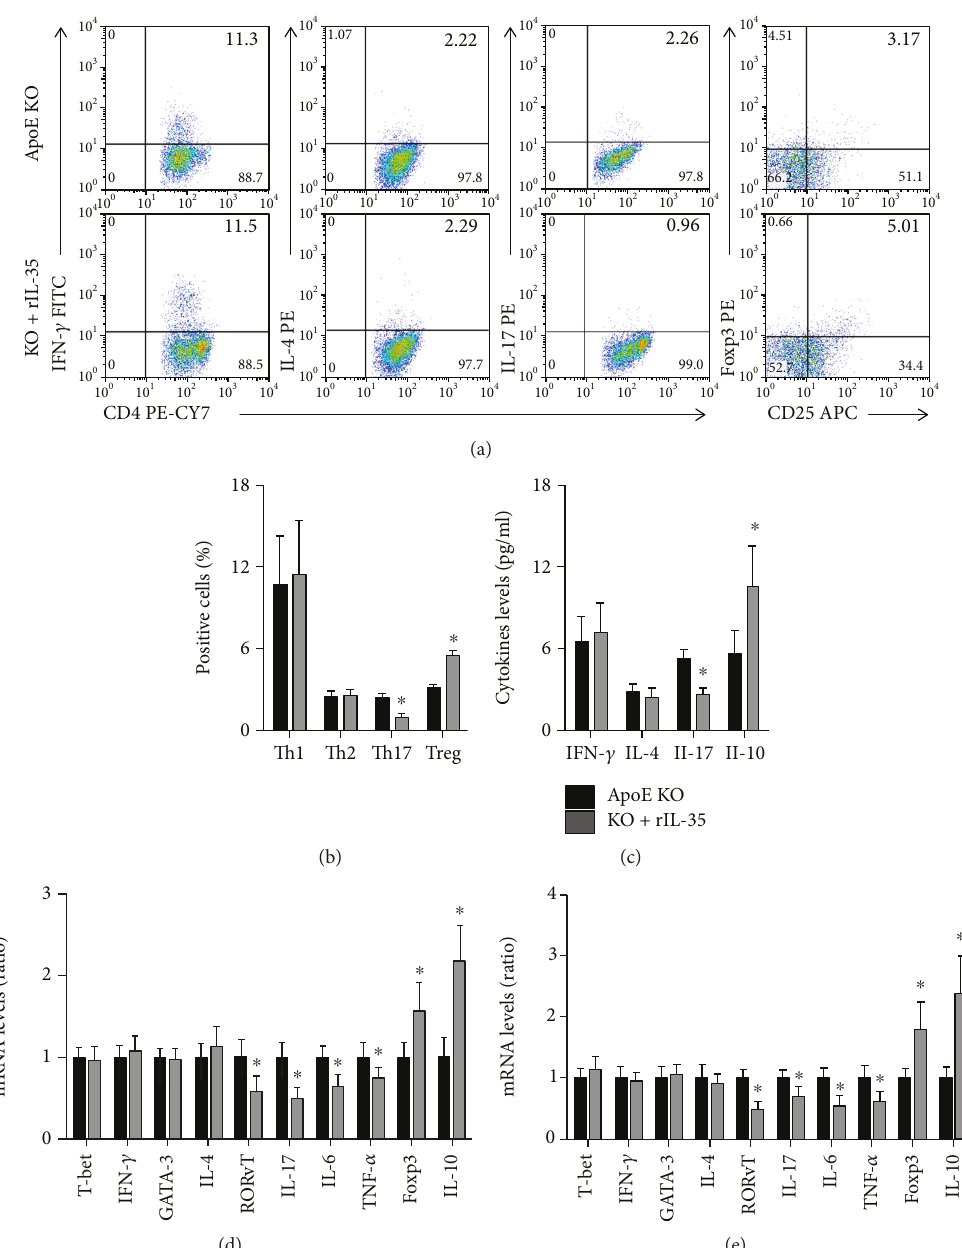
Figure 6: E ff ect of rIL-35 on the activity of CD4+ T cells. (a, b) The frequency of Th1, Th2, Th17, and Treg in the ApoE-/- and ApoE-/-+rIL-35 groups was measured by fl ow cytometry; n = 10 for each group. (c) The serum IFN- γ , IL-4, IL-17, and IL-10 levels were detected by ELISA; n = 16 for each group. (d, e) The mRNA levels of T-bet, IFN- γ , GATA3, IL-4, ROR γ T, IL-17, IL-6, TNF- α , Foxp3, and IL-10 in the spleens and aortas of these two groups were analyzed by RT-qPCR. ApoE KO=ApoE-/-, DKO=ApoE-/- IL-12p35-/-; N = 6 for each group. ∗ P < 0 05 vs. the ApoE-/-